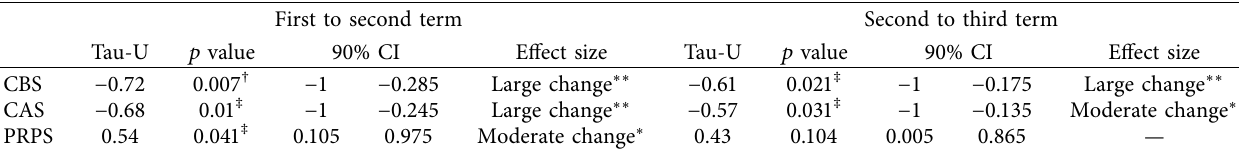
Table 3: Tau-U effect sizes for each term change in the outcomes.